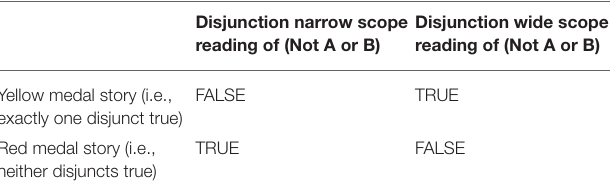
TABLE 1 | Possible responses for test items depending on the relative scope of negation and disjunction in the different story